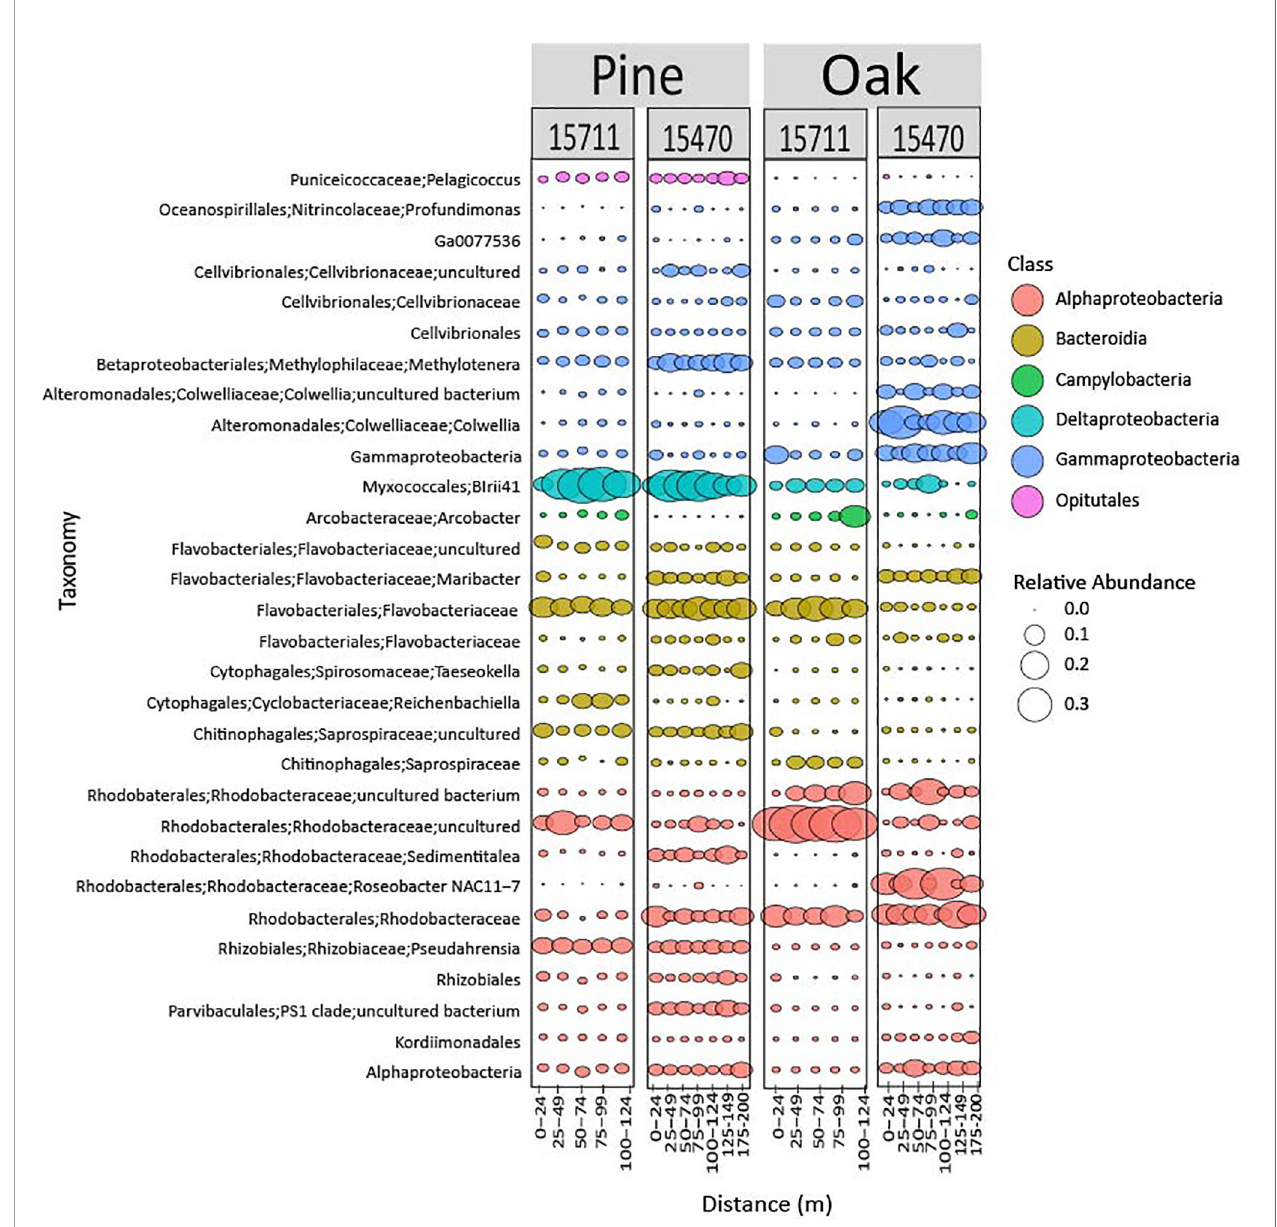
FIGURE 4 | Bubble plot representing the 30 most abundant bacterial taxa from both sites and wood types. Samples are grouped in distance categories spanning 25